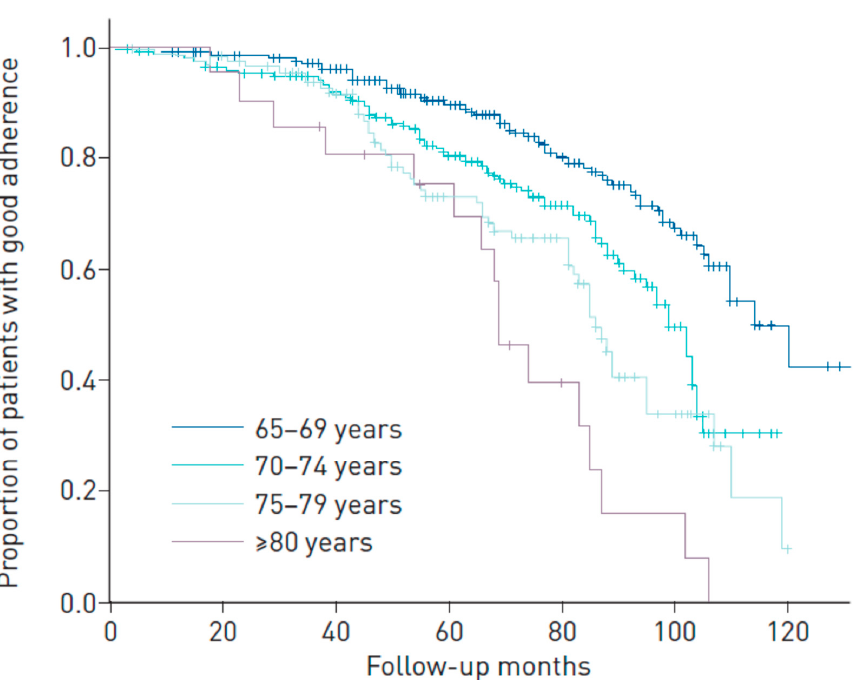
Figure 1. Kaplan-Meier curves according to age group for the percentage of patients with a CPAP compliance of at least four hours / day during follow-up. Martinez-Garcia et al. ERJ Open Res. 2019 Mar 4;5(1). pii: 00178-2018, with permission.